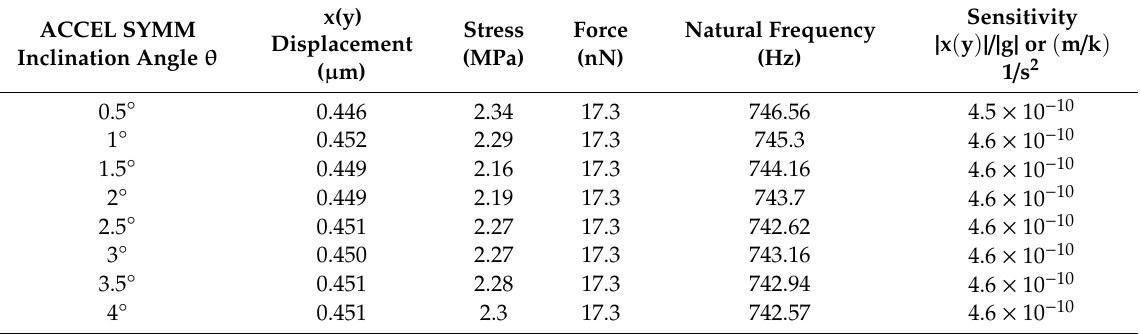
Table 14. Parameters of symmetric beam accelerometer (W b1 = W b2 / 3), at di ff erent angle